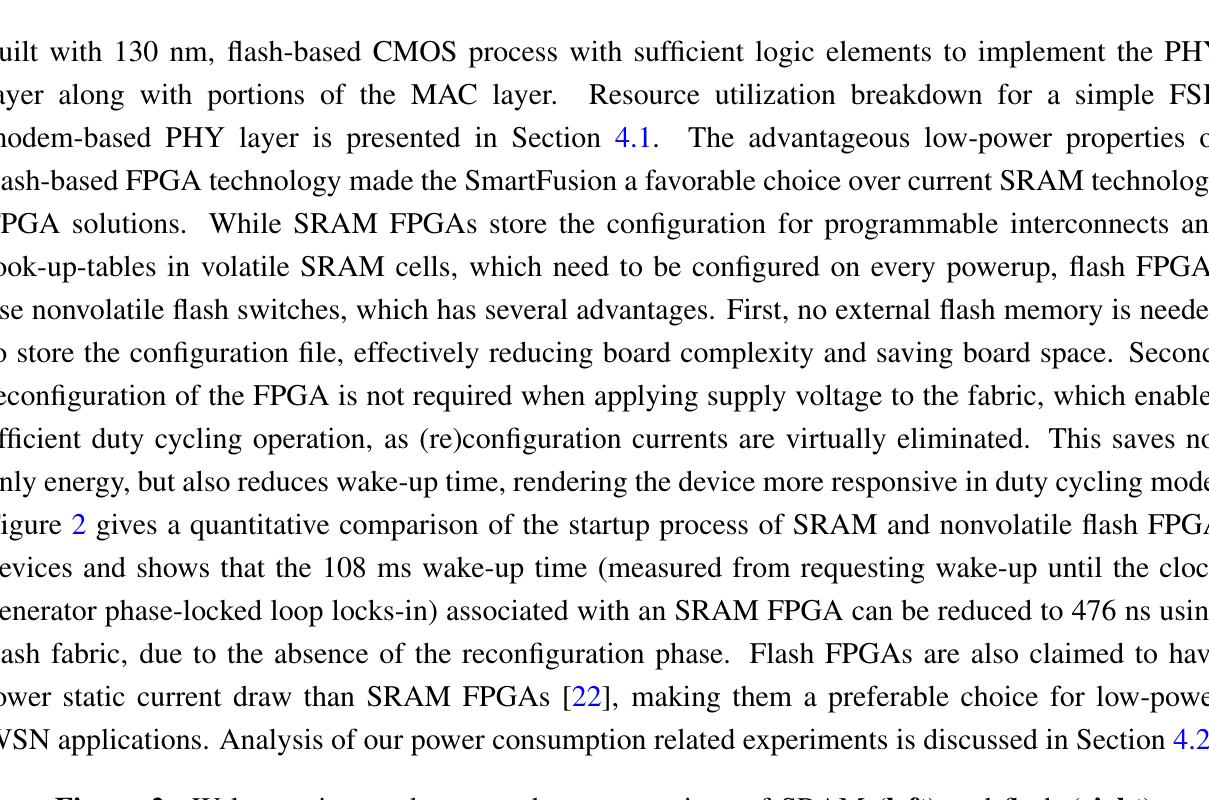
Figure 2. Wake-up time and current draw comparison of SRAM ( left ) and flash ( right ) FPGAs measured with development kits that utilize similar size SRAM and flash